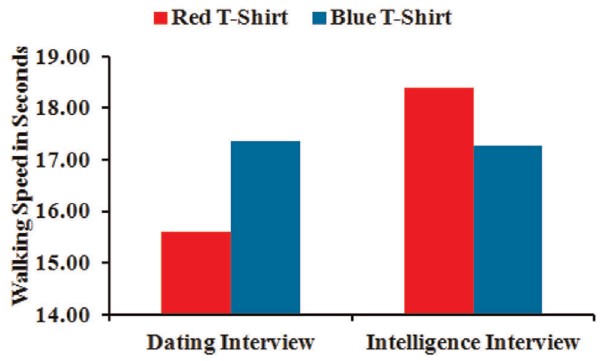
Figure 2. Walking Speed Means for the Context x Color